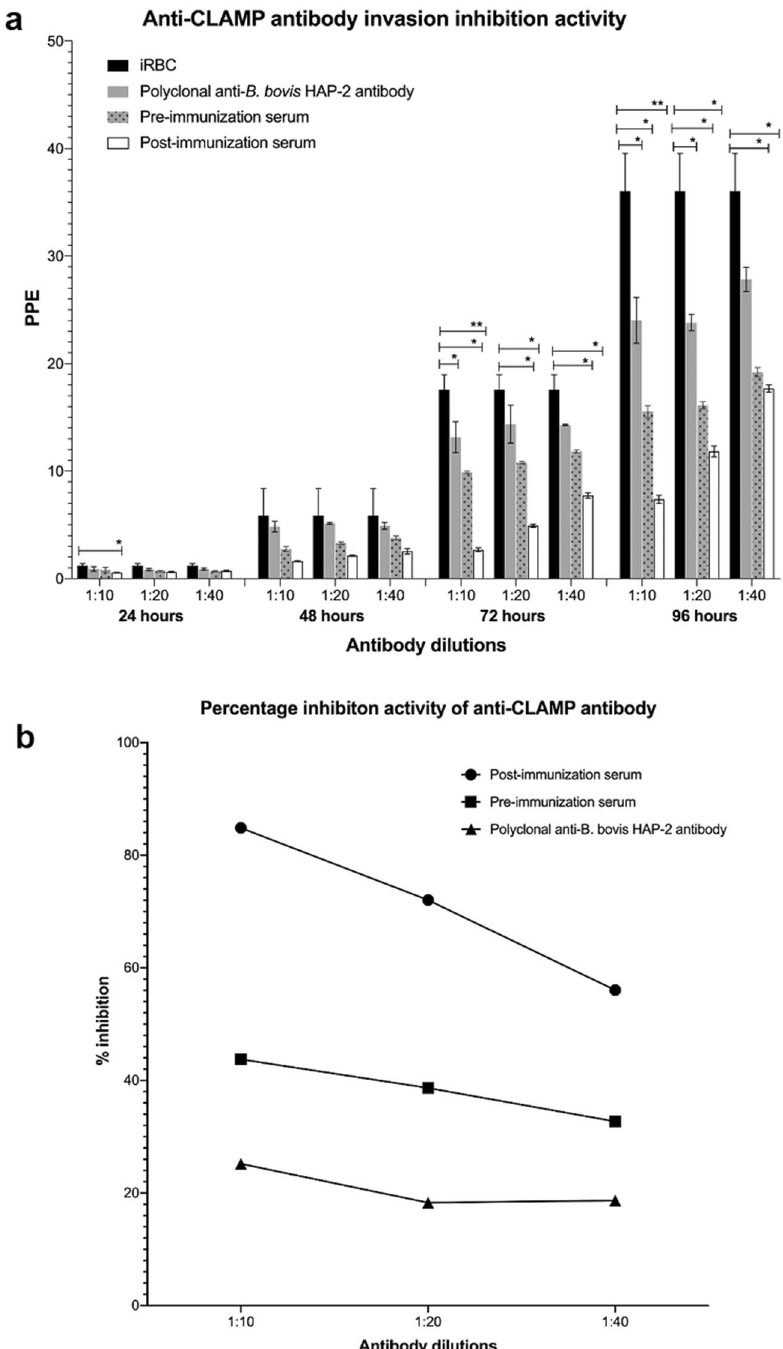
Figure 5. Polyclonal anti-CLAMP antibody significantly inhibits invasion of equine erythrocytes by T. equi . ( a ) In vitro neutralization assay data showing invasion inhibition activity of the CLAMP-specific antibody (post-immunization serum), pre-immunization serum and polyclonal anti- B. bovis HAP-2 antibody at different dilutions over time. T. equi infected erythrocytes cultured in the presence of CLAMP-specific antibodies were significantly less parasitized (PPE) compared to parasites cultured in the presence of pre-immunization serum and the polyclonal anti- B. bovis HAP-2 antibody. Control represents T. equi infected red blood cells (iRBC) cultured in the absence of both pre- and post-immunization sera. * p < 0.05, ** p < 0.0090. ( b ) Anti-CLAMP antibodies inhibit a significant percentage of parasites from invading erythrocytes at 72 h post- infection. Percentage inhibition was calculated as the difference between percentage inhibition in the presence of polyclonal anti-CLAMP antibodies (post-immunization serum) and percentage inhibition in the presence of pre-immunization serum. In this regard, anti-CLAMP antibodies in the post-immunization serum inhibited parasite invasion by 41%, 33.4% and 23.3% at 1:10, 1:20 and 1: 40 dilutions, respectively. Factors present in the B. bovis HAP-2 post immunization serum (polyclonal anti- B. bovis HAP-2 antibody) also minimally inhibited